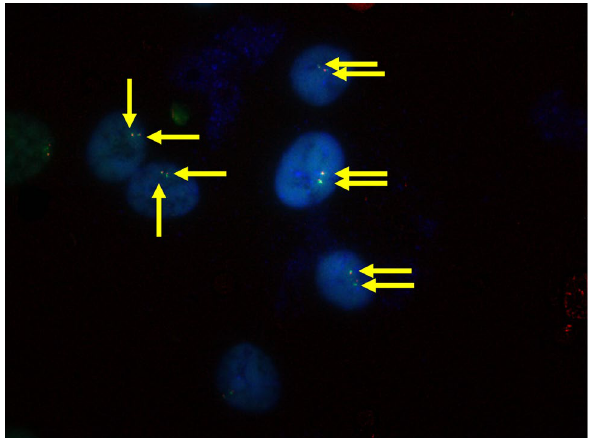
Figure 2. Typical positive results of NONO-TFE3 dual-fusion FISH assay in UOK 109 cell (2F, yellow arrowheads).